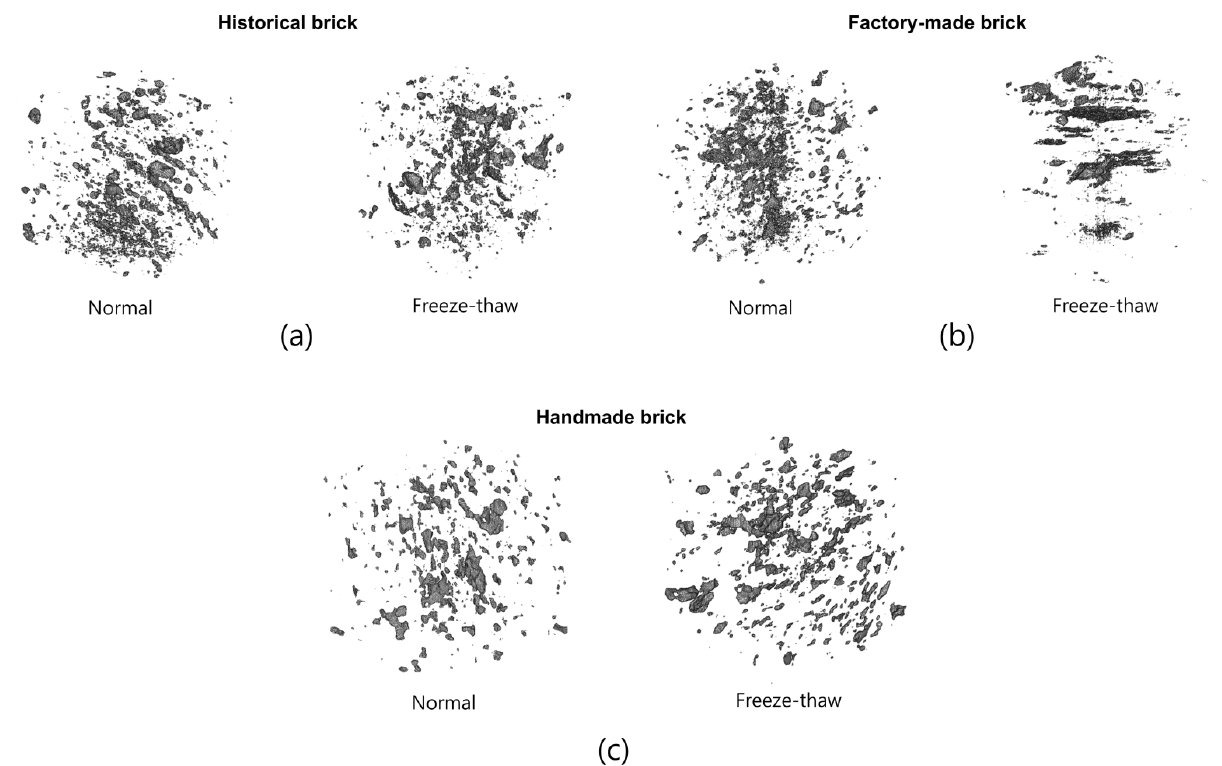
Figure 6. Volumetric pore images of ( a ) historical bricks, ( b) factory-made bricks, ( c ) handmade bricks (in each case, the left hand side image shows the pore structure in the normal state, while the right hand side image is of the pores after the freeze-thaw cycles.).